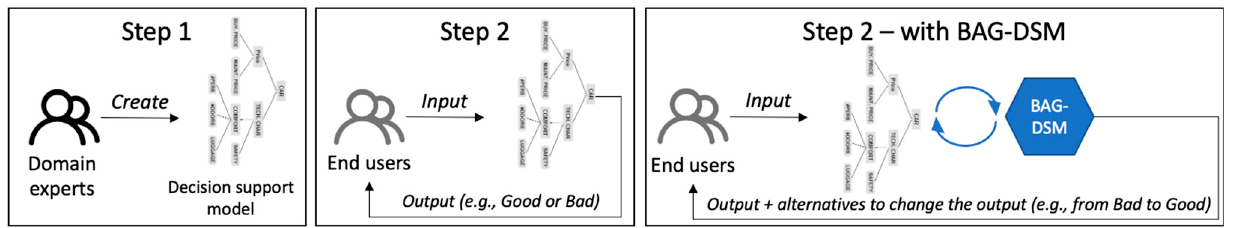
Figure 1. Differences between a typical usage of decision support models (Step 1 and Step 2) and augmented usage with BAG-DSM (Step 1 and Step 2—with BAG-DSM).